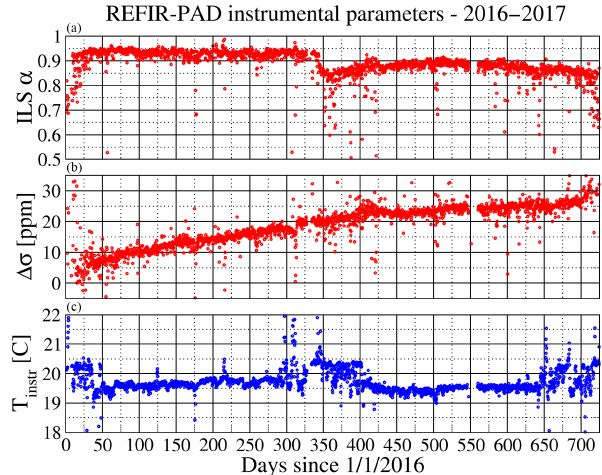
Figure 17. Time series of ozone and nitrous oxide columnar val- ues retrieved from the REFIR-PAD measurements acquired in the September 2017–April 2018 period. For reference, corresponding OMI measurements over the Dome C region pixel are also shown.